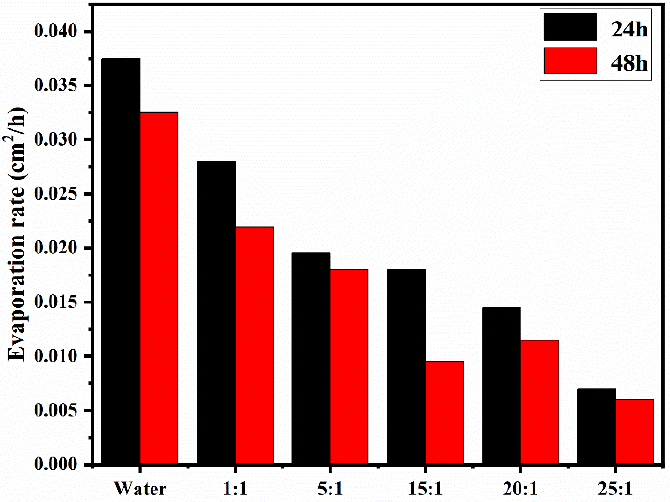
Figure 6. Evaporation rates of PBA-g-PDMAEMA aqueous solutions within 24 h and 48 h.